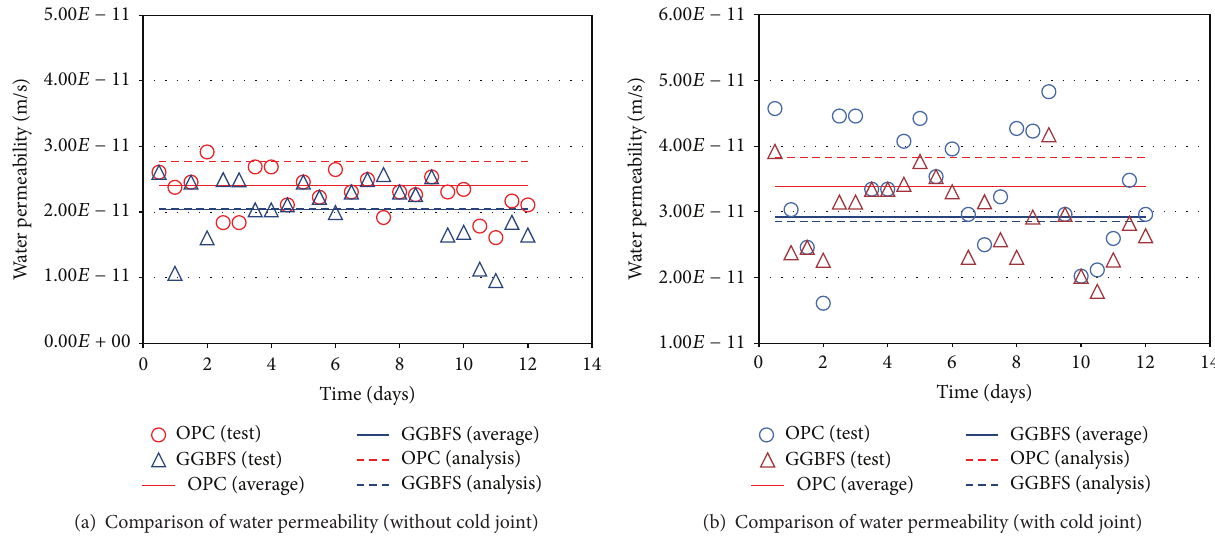
Figure 13: Comparison of water